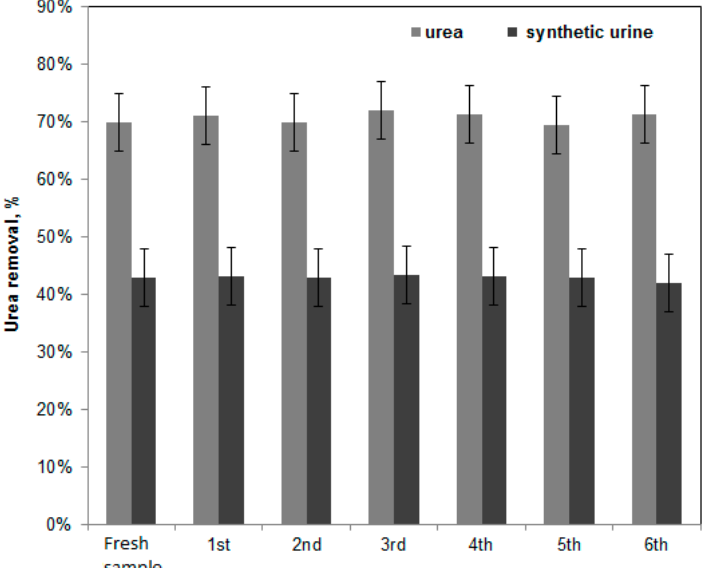
Figure 6. Urea degradation after 360 min of irradiation at different repetitions, using PS-VD LED dimming modulation, in the presence of distilled and synthetic urine water. Urea initial concentration: 25 g/L; solution volume: 250 mL; N-TiO 2 /PS amount: 120 g.